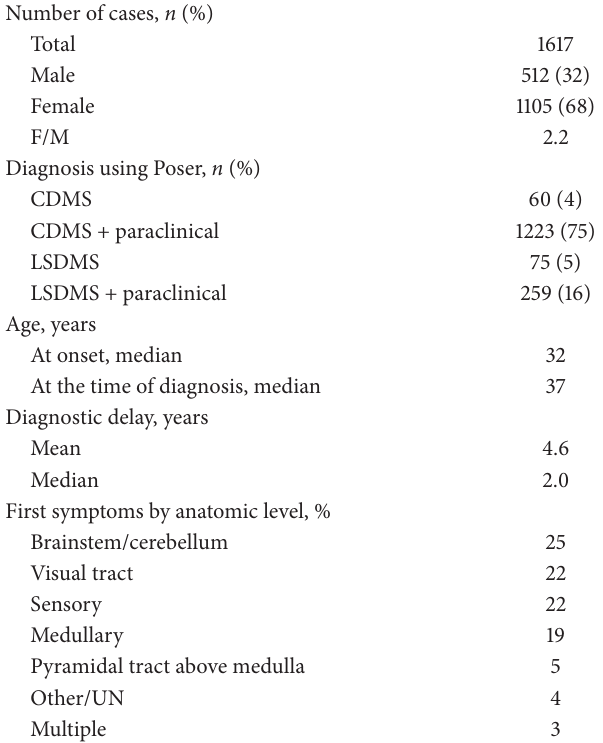
cases diagnosed during 1981–2010 in hospital districts of Pirkanmaa, Sein¨ajoki, and Vaasa. There were no men in the 10–19 group in